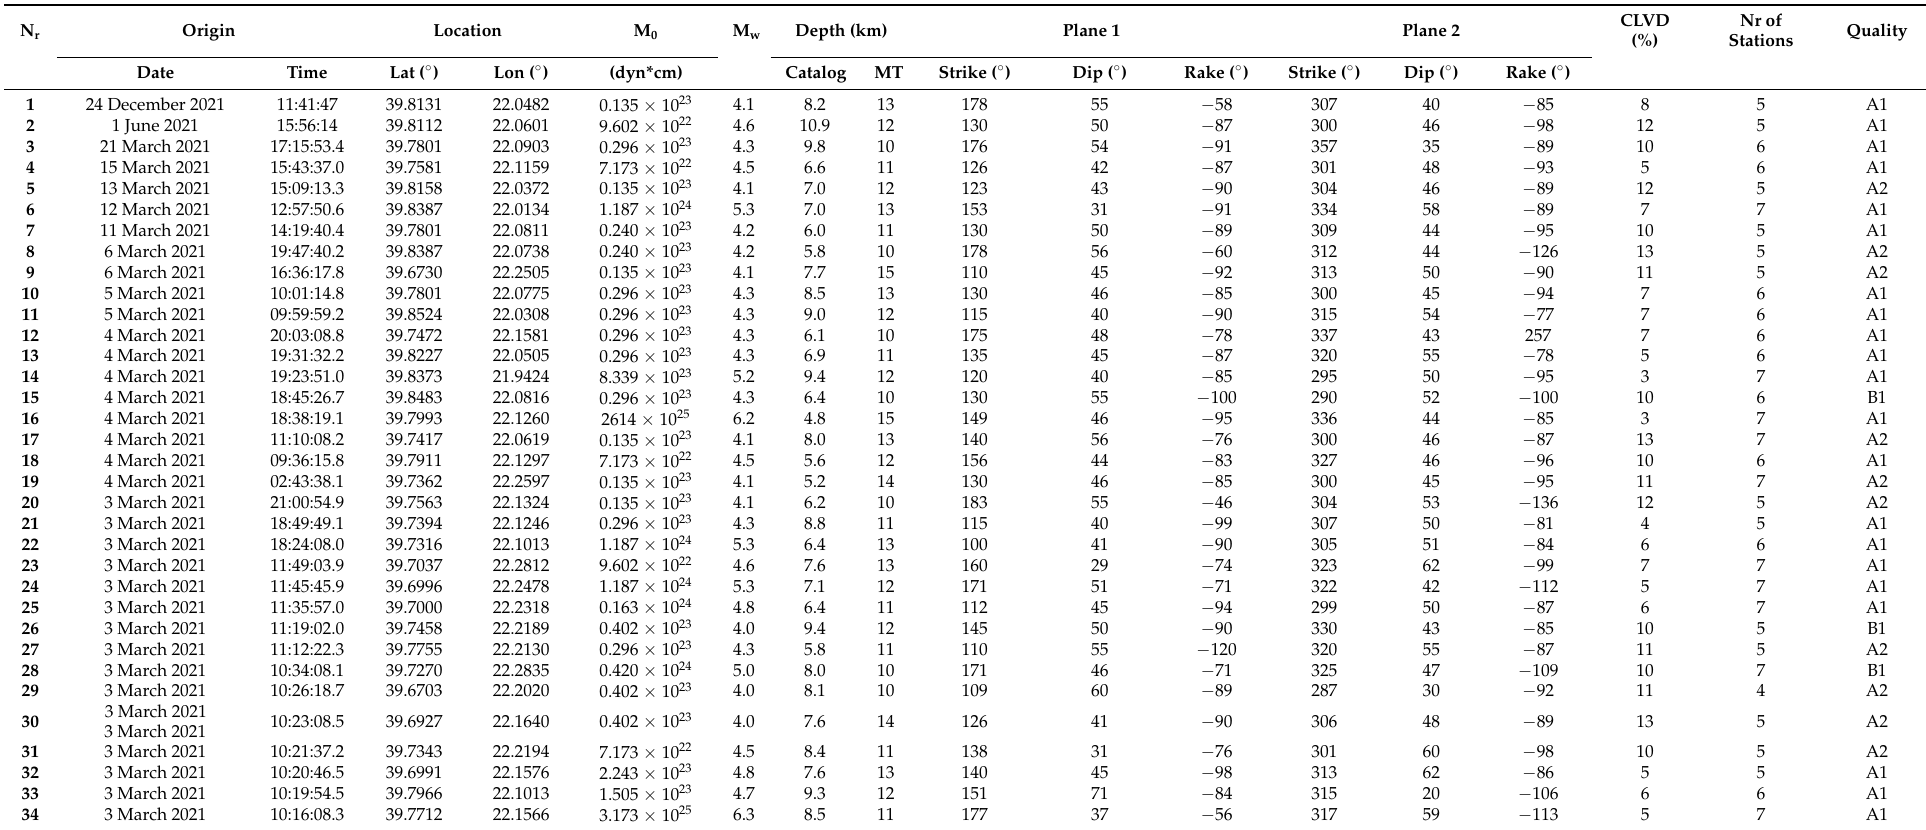
Table A1. Source Parameters of the main events and intermediate magnitudes for the Elassona seismic sequence for 03 March 2021–31 December 2021. Nr is the event number; Lat and Lon are the geographical coordinates of each event as calculated by the National Observatory of Athens; M 0 is the seismic moment in dyn*cm; M w is the moment magnitude; the strike, dip, and rake of the two nodal planes were the seismic parameters as calculated from the inversion; CLVD is the percentage of the compensated linear vector dipole, which describes seismic sources with no volume changes; Ns is the number of stations used in inversion; finally, Q is the quality of the solution depending on the misfit and the percentage